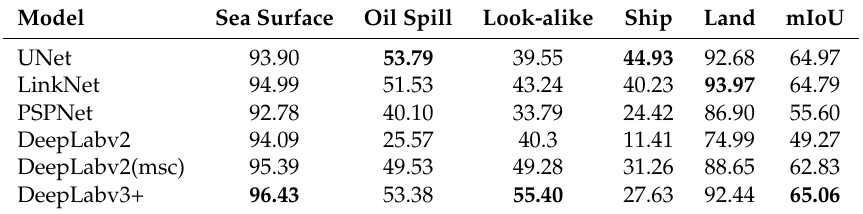
Table 4. Comparison of segmentation models in terms of intersection-over-union